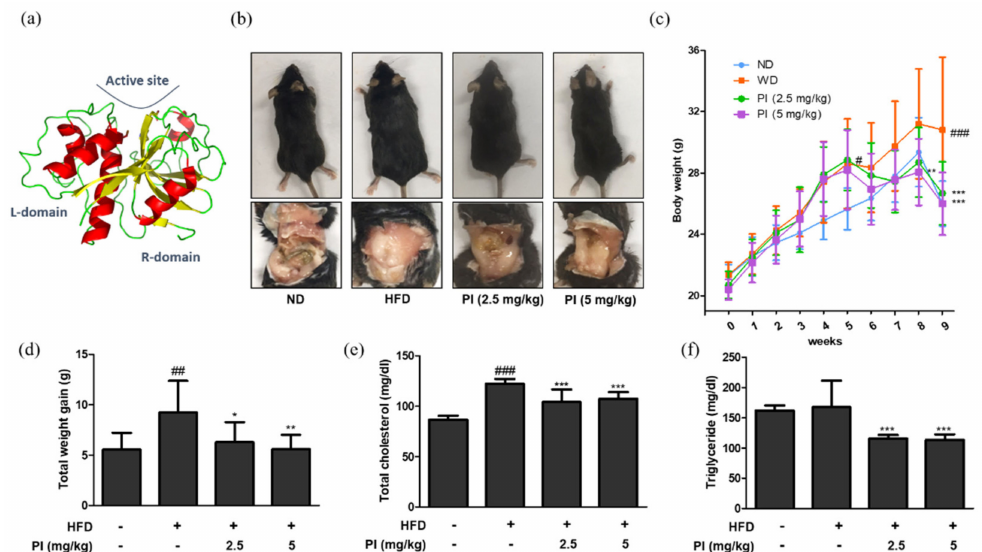
Figure 1. Effects of papain on macroscopic changes and serum profiles in HFD-induced obese mice. ( a ) Three–dimensional structure of papain. ( b ) Representative macroscopic pictures of HFD–induced obese mice from different groups; C57BL/6 mice (upper panel) and abdomen of mice (lower panel). ( c ) Body weight and ( d ) weight gain were measured once a week for a duration of 9 weeks. A comparison was made between the total weight gain obtained at the last week compared to the first week. ( e ) Serum levels of total cholesterol and ( f ) triglyceride in HFD-induced obese mice. The values are given as the mean ± SD ( n = 6). # p < 0.05, ## p < 0.01 and ### p < 0.001 vs. ND group; * p < 0.05, ** p < 0.01 and *** p < 0.001 vs. HFD